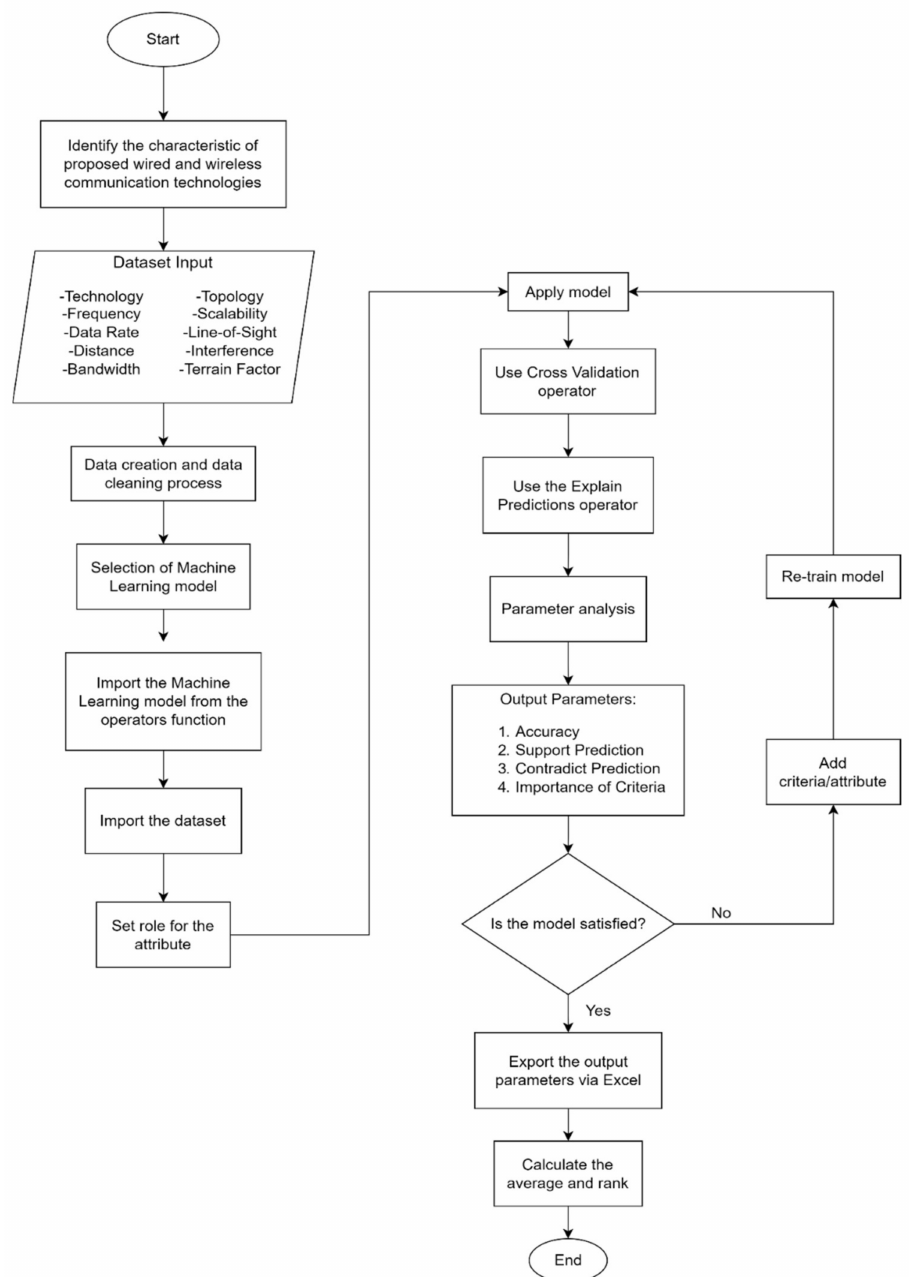
Figure 1. The methodology of this